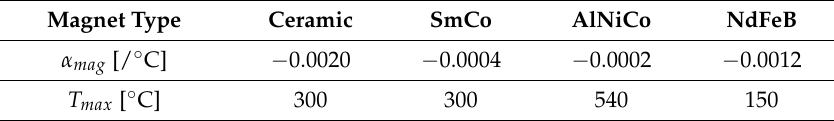
Table 1. Magnet temperature coefficient and temperature limit for various magnet types.